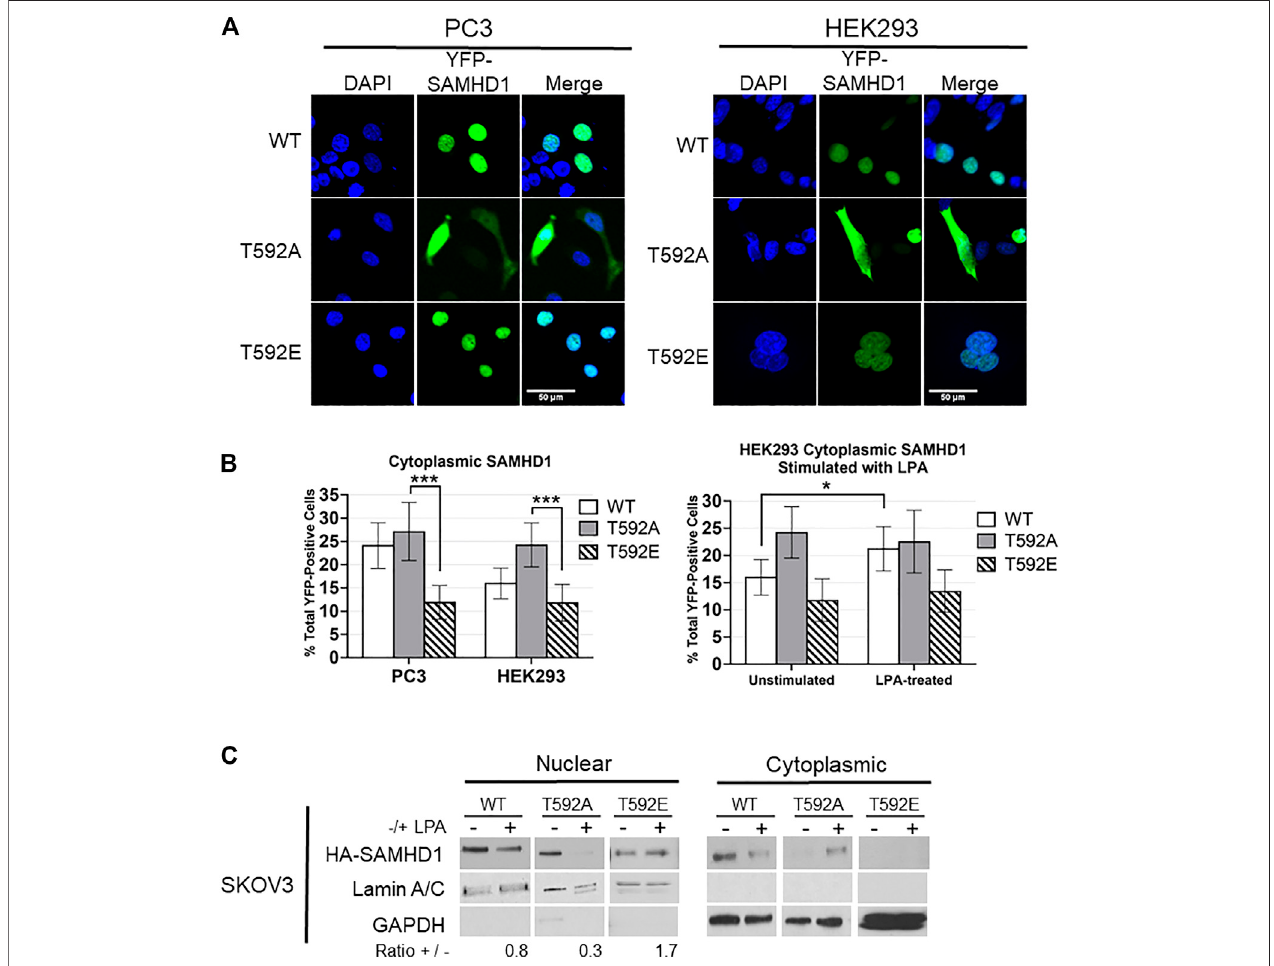
FIGURE 1 | SAMHD1 phosphorylation affects localization. (A) Fluorescent confocal microscopy of PC3 and HEK293 cells expressing YFP-SAMHD1 (green) with DAPI stain (blue). (B) Percentage of YFP-positive cells with cytoplasmic SAMHD1. Error bars represent 95% highest density intervals. * p < 0.05, *** p < 0.001, Fisher ’ s exact test. A minimum of 200 cells per time point were counted from 3 (HEK293) or 4 (PC3) independent experiments. (C) Cytoplasmic and nuclear fractionation of SKOV3 cells expressing HA-SAMHD1. Lamin A/C and GAPDH serve as loading and fractionation controls. Densitometry was performed to determine the ratio of post-treatment to pre-treatment nuclear SAMHD1 after normalizing to the Lamin A/C loading control. Blot is representative of three independent